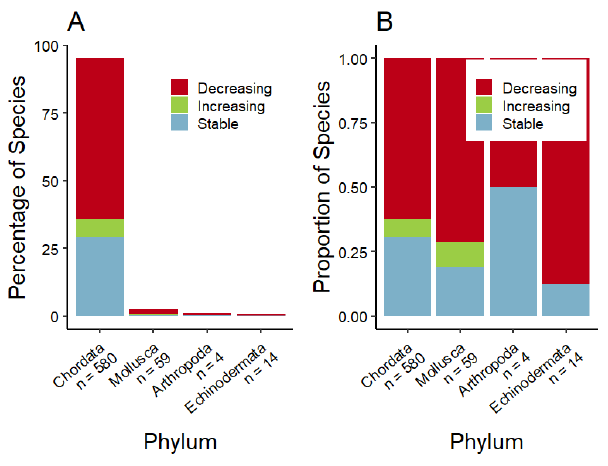
Fig. 1. The proportion of medicinal use species in each phylum and IUCN Red List species population trend, shown as a percentage of species in each phylum (A) and proportion of phylum classified according to population trend